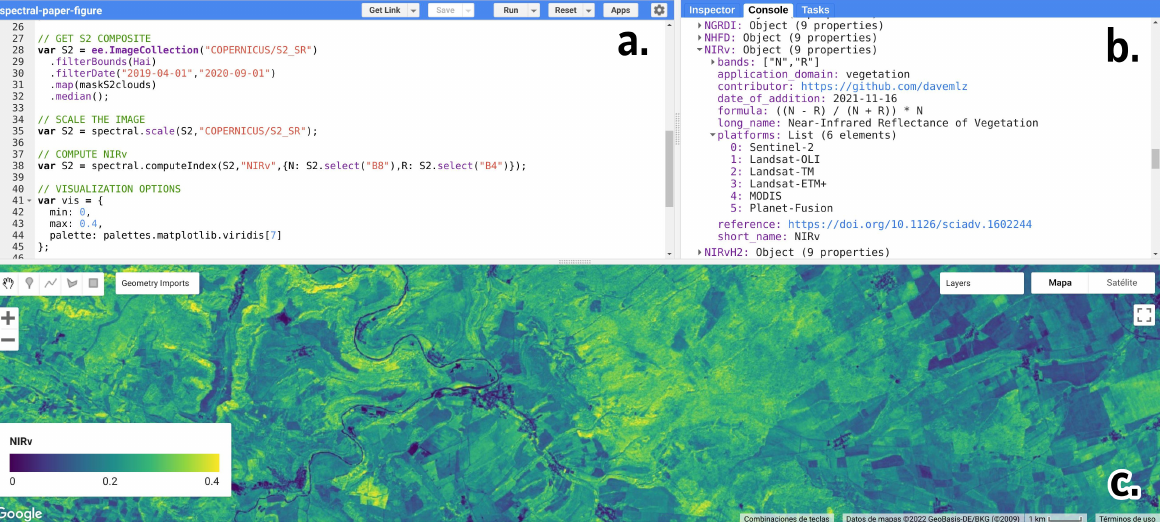
Figure 1. Functioning of the module inside the GEE Code Editor. a) Script tab that shows the functions used for computing spectral indices, b) console tab showing the set of spectral indices of the catalogue after being queried (the NIRv is displayed with its attributes as an example), c) map visualization of the NIRv computed using the module for Sentinel-2 over the Hainich National Park in Central